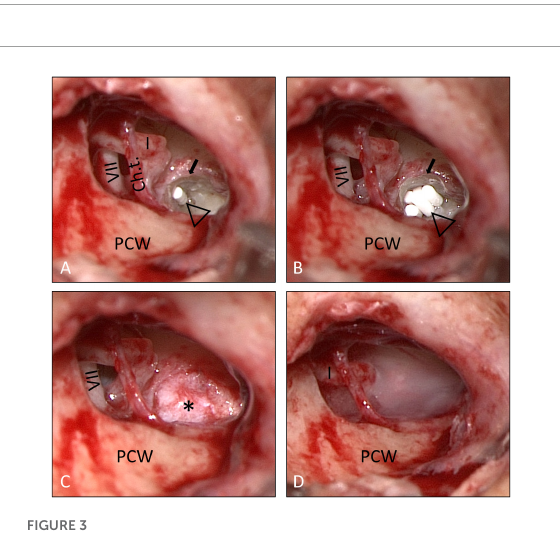
FIGURE3 Surgical procedure (patient No. 14, right ear). (A,B) The bony rim of the RW niche was drilled away (small arrow) to allow a better view onto the entire RWM. The implants (open triangle) were then covered with soft tissue ( ∗ ) (C) , which was secured in place with fibrin glue (D) . See also Supplementary video material . Ch.t.: Chorda tympani; I: long process of incus; PCW: posterior canal wall; VII: facial